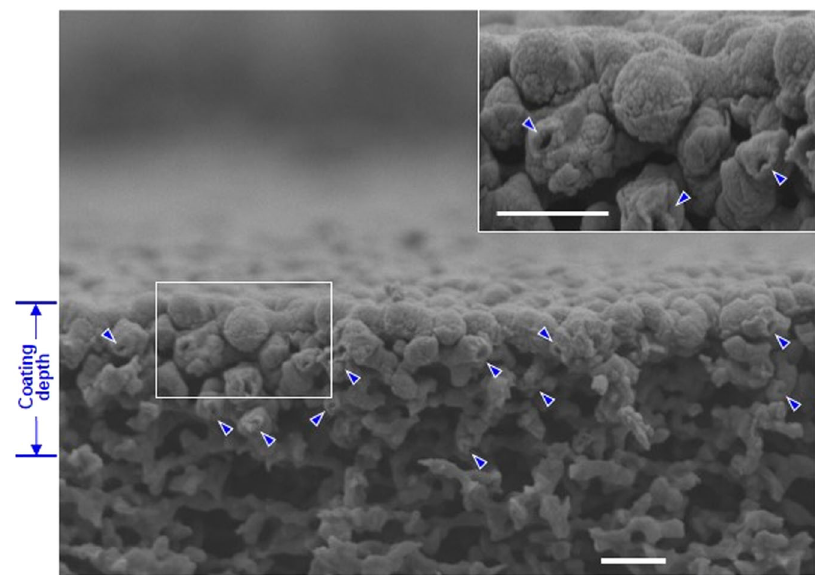
Fig. 2 Microstructure of a coated MCE membrane. Cross-sectional SEM micrographs of coated MCE membrane. Inset is a zoomed view of white-framed area. Blue arrows indicate voids resulting from the forcible removal of fi bers during sample cleavage in liquid nitrogen. White scale bars indicate 1 µm.